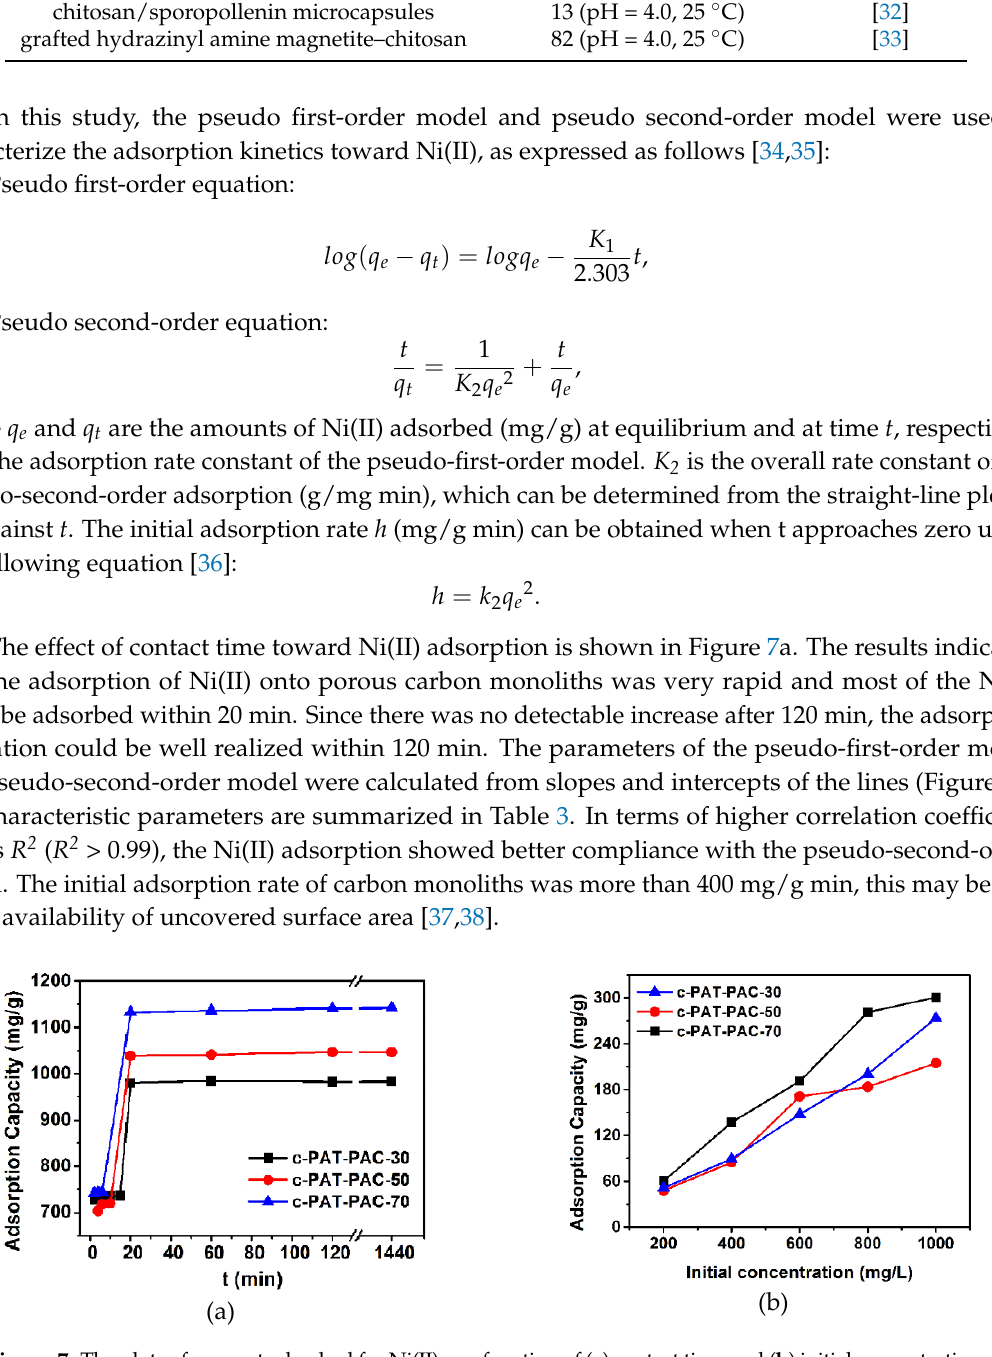
Figure 7. The plots of amount adsorbed for Ni(II) as a function of ( a ) contact time and ( b ) initial concentration.